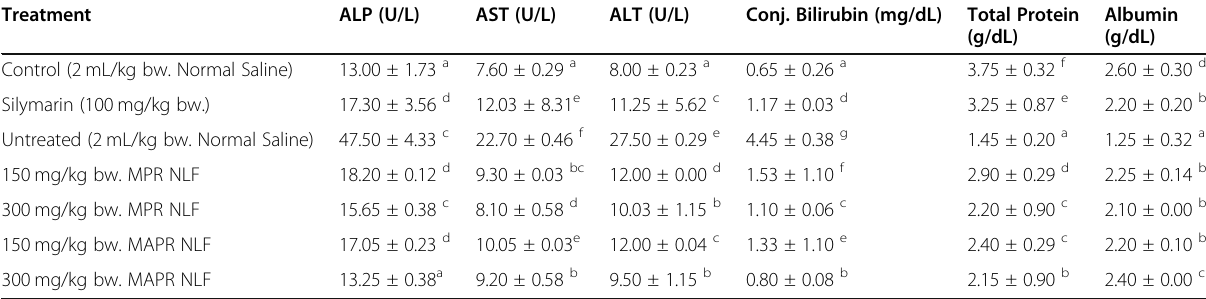
Table 6 Liver damage biomarkers of male Wistar rats administered with lead acetate and treated with methanol and methanol/ acetone phenolic-rich extracts of N. latifolia fruit Treatment Control (2 mL/kg bw. Normal Saline) Silymarin (100 mg/kg bw.)